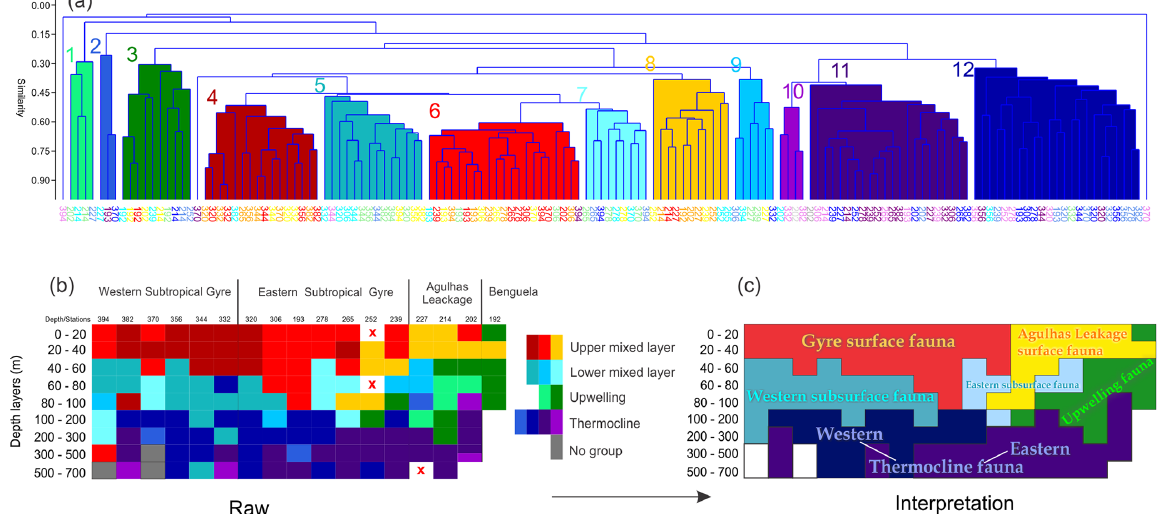
Figure 7. (a) Cluster analysis of relative community composition in all stations and depths sections. (b) Graphical representation of clustered groups along the whole transect. Samples without living specimens are highlighted with an “x”. (c) Zonally and vertically interpreted communities across the subtropical South Atlantic. Station names were placed with warm to cold colors in (a) and (b) in order to separate and locate different depth layers. The main species contribution for each group is shown in Table 3.